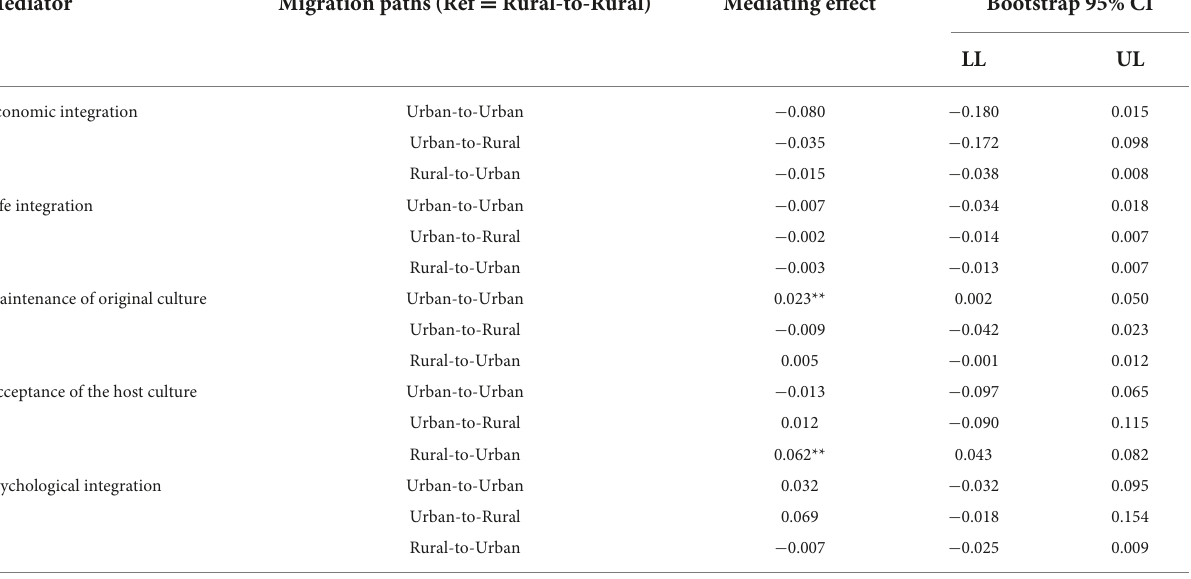
TABLE 4 The mediating effect of social integration on the association between migration paths and perceived stress of new-generation